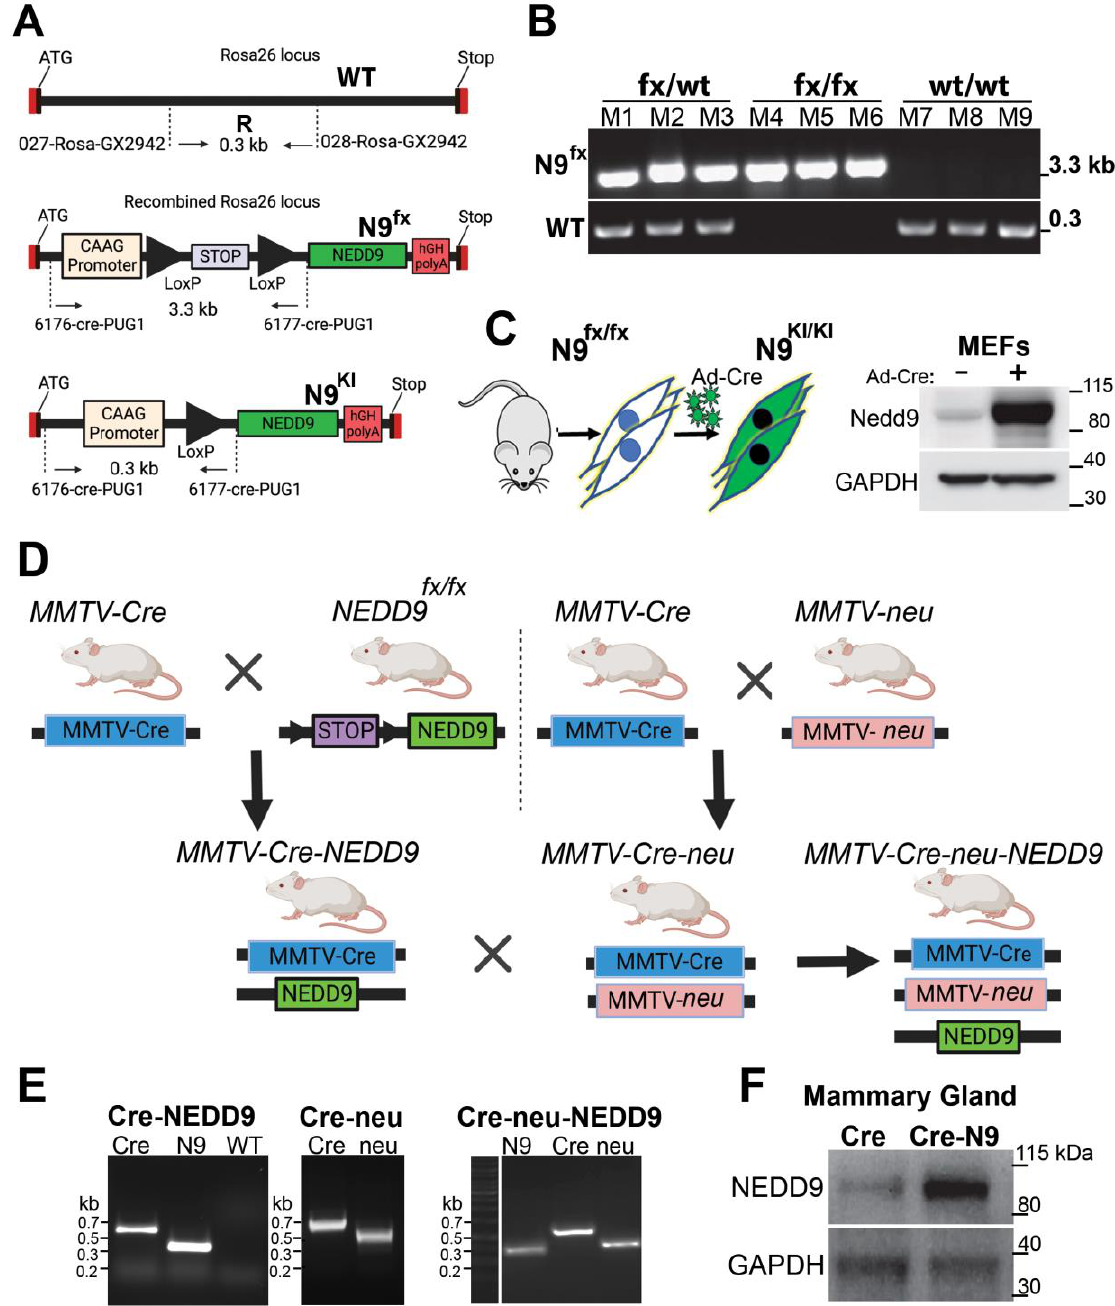
Figure 2. Design and expression of Cre inducible NEDD9 knock-in mouse model. ( A ) Design of Cre recombinase-inducible NEDD9 cDNA knock-in vector for homologous recombination at the Rosa26 locus (top). In the presence of Cre recombinase, the stop cassette is resected out of the genome due to flanking LoxP sites (middle), resulting in CAAG promoter-driven NEDD9 expression (bottom). ( B ) Genotyping results in triplicate, indicating the presence of either the heterozygote (fx/wt) (M1- 3), homozygous (fx/fx) (M4-6), or wild type Rosa26 loci (wt/wt) (M7-9). ( C ) Schematic outline of adenovirus Cre delivery into mouse embryonic fibroblasts (MEFs), isolated from NEDD9fx/fx mice (n = 3). MEFs were incubated with GFP ( − ) or adenoviral GFP-Cre (+) virus particles. Western blot analysis of MEF’s lysates with anti -NEDD9. -GAPDH is a loading control. ( D ) Mating scheme of mice used in study. ( E ) Representative genotyping results of mice (genotypes as indicated in ( D )),